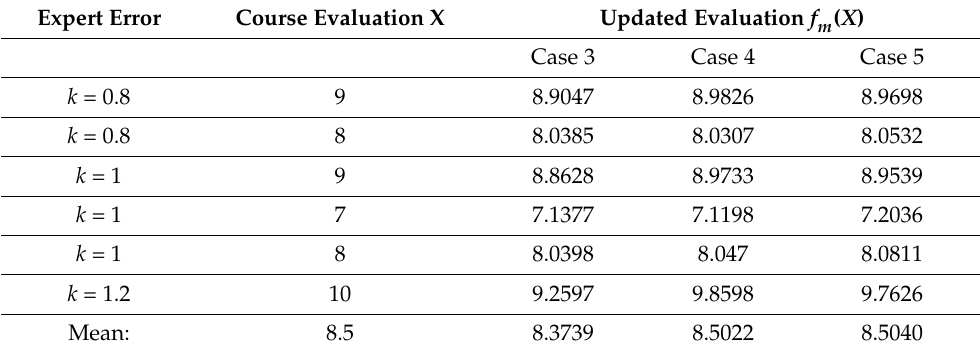
Table 10. Machine learning and neural networks’ course evaluations; µ = 8.638 , σ = 1.463. Expert